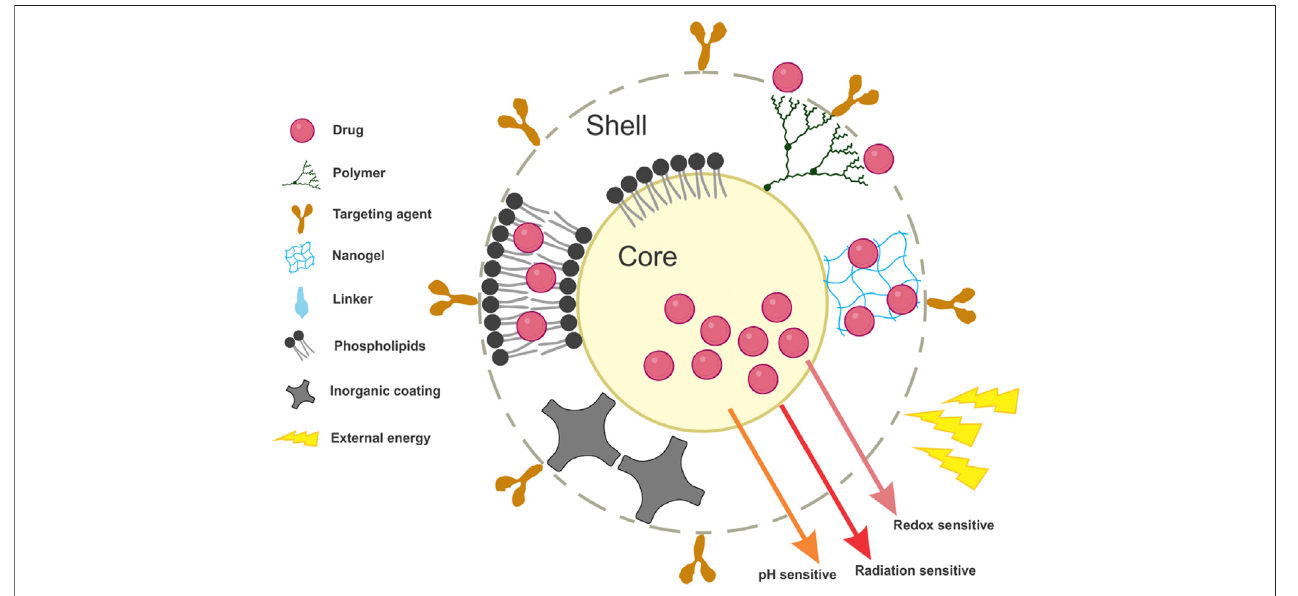
FIGURE 1 | Schematic representation of a nanostructure for drug